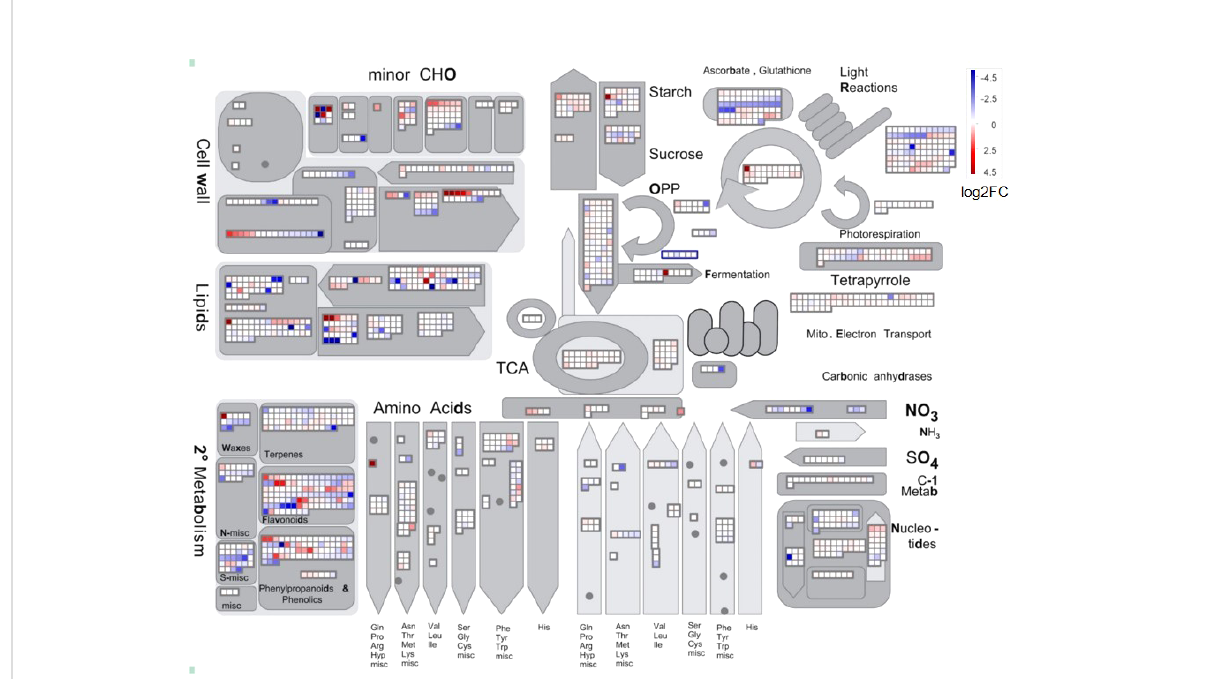
FIGURE 3 MapMan analysis of DEGs in L. japonica under chilling treatment for 30 days. The genes expression was compared between SP and T30. The Log2FC values of the gene expression were used for MapMan visualization using MapMan software to obtain an overview of the affected metabolic processes. Each colored square indicates the Log2FC value of a differentially changed gene. Red, blue, and white colors indicate an increase, decrease, and no change in the Log2FC value of gene